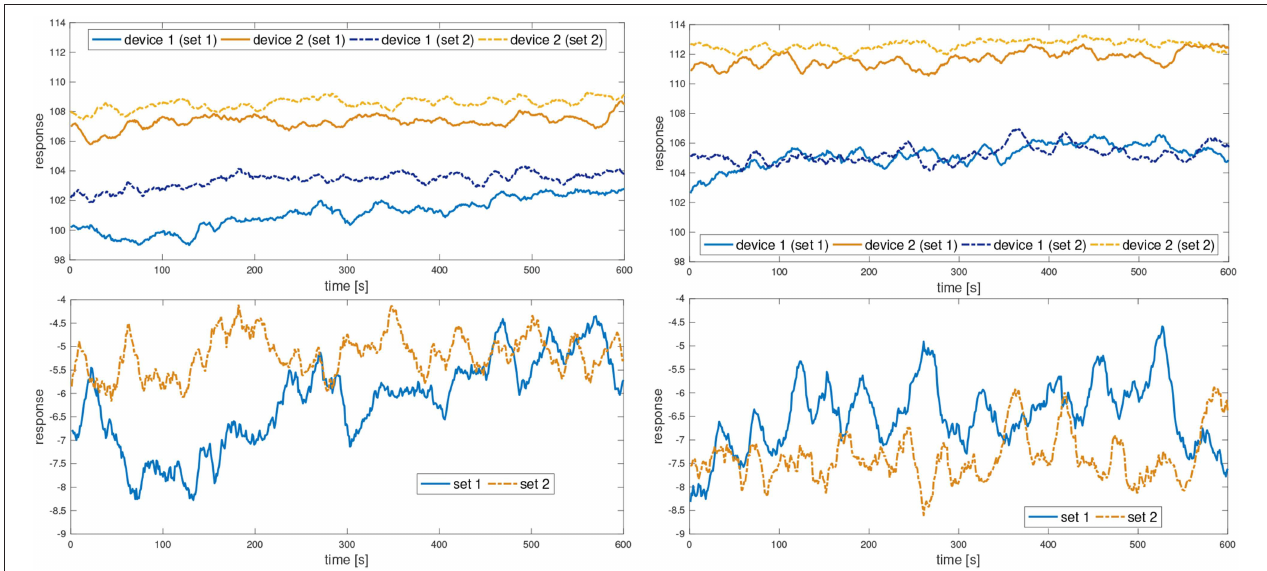
FIGURE 5 | Results of device heterogeneity analysis. Upper row shows temporal responses on IMS channel 1 by two identical ChemPro100i devices measured in our lab (Left) and in a meeting room (Right) . Lower row shows the corresponding differences between the responses of both eNoses for both measurement sets of each